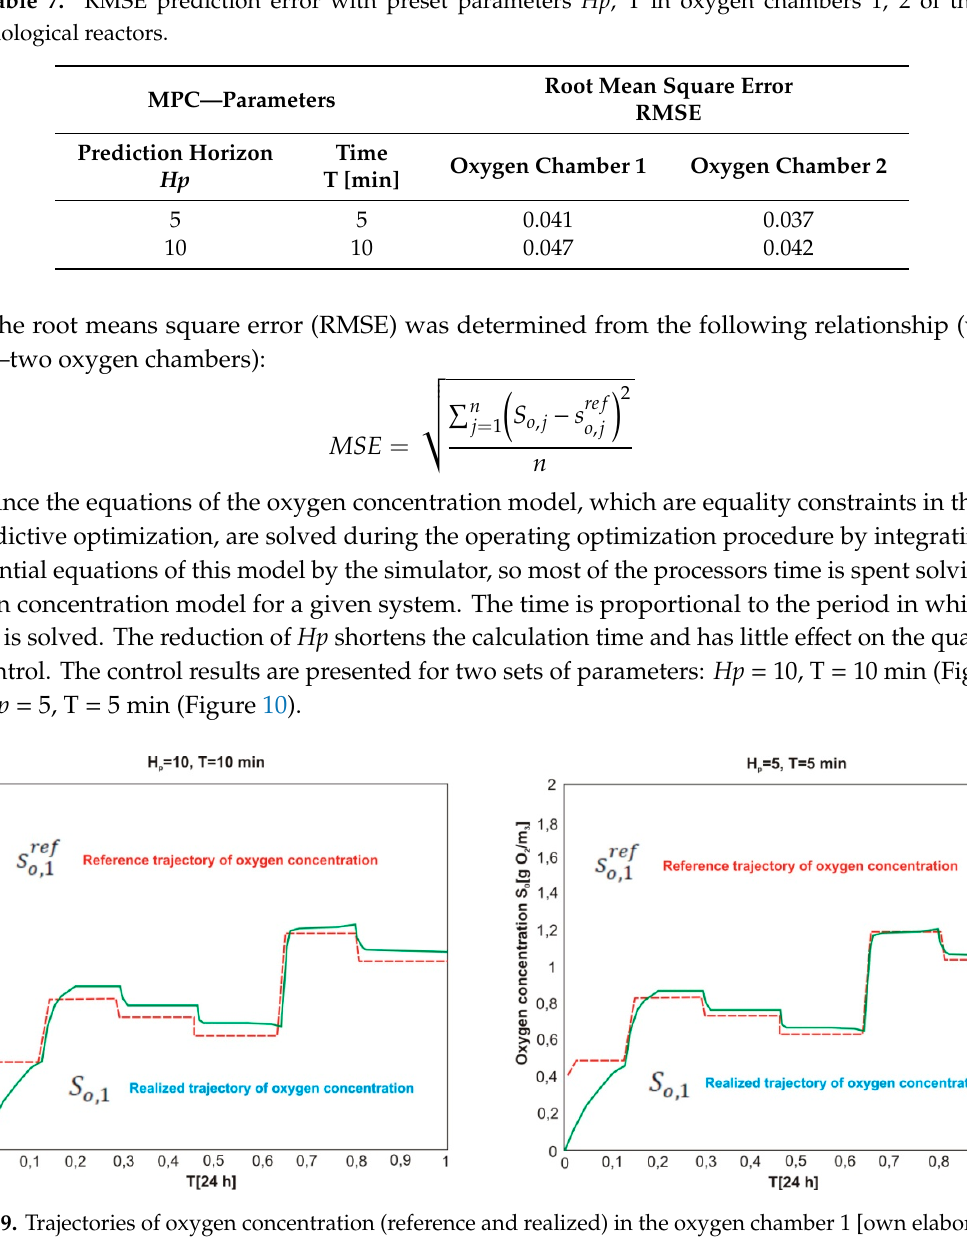
Figure 10. Trajectories of oxygen concentration (reference and realized) in the oxygen chamber 2 [own elaboration]. When optimizing the electricity consumption of actuators in the system of biological reactor, special attention was paid to the required degree of wastewater treatment, in order to ensure the quality parameters of wastewater in compliance with the accepted standards. For the analyzed sewage treatment plant, whereof capacity is 165,000 RLM, the concentration of total nitrogen in the treated wastewater should not exceed 10 mg/L, and the concentration of total phosphorus should not exceed 1 mg/L. The highest permissible values for the individual nitrogen compounds should be 10 mg/L for NH 4 + ammonium nitrogen, 30 mg/l for NO 3 - nitrate nitrogen and 1 mg/L for NO 2 - nitrite nitrogen, respectively. The analysis involved also the changes of dissolved oxygen concentration in the nitrification chamber in relation to the electric energy consumption by the actuators. When conducting the analysis of computer simulation, we assumed the concentration of dissolved oxygen in the activated sludge chambers in the range of 0.5 to 2 mg/l. The changes in the concentration of ammonium nitrogen (NH 4+ -N) and nitrate nitrogen (NO 3 -N) are presented in Figure 11.